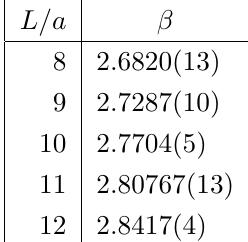
Table 6 . Couplings corresponding to g 2 = 4 : 85 in the SU(2) theory, as a function of L=a .